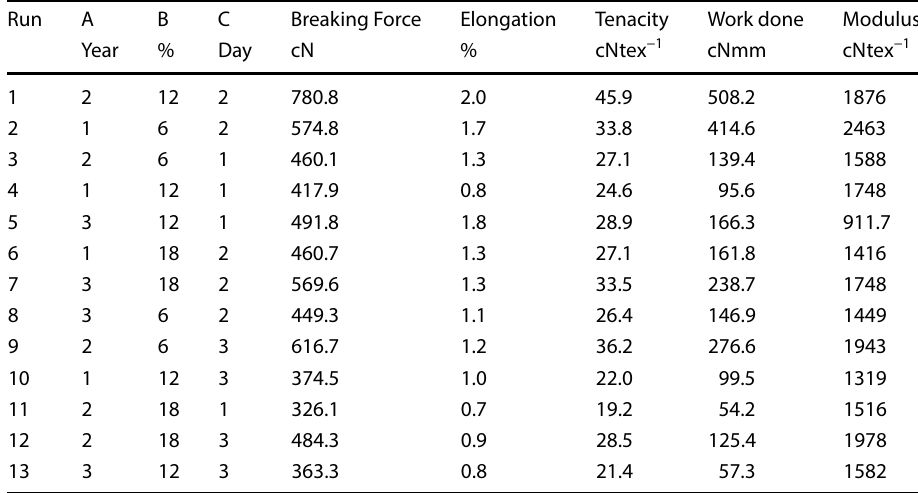
Table 4 Experimental design factors and responses values from design expert